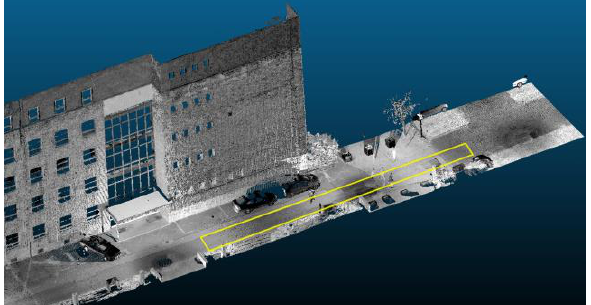
Figure 2. The analyzed road surface visualized with the TLS captured point